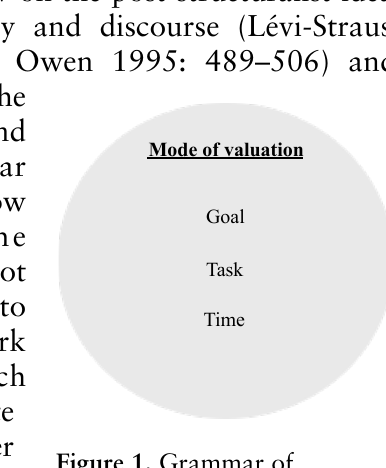
Figure 1. Grammar of assessment. Source: